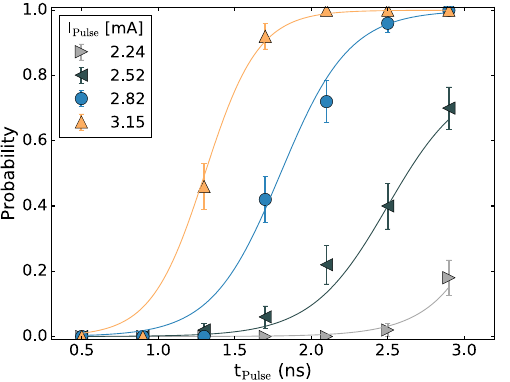
Figure 2. The annihilation probability versus pulse duration at different pulse amplitudes. Pulses were added to a dc current of 13.5 mA and a 0.7 T field was applied. The lines are guides to the eye.